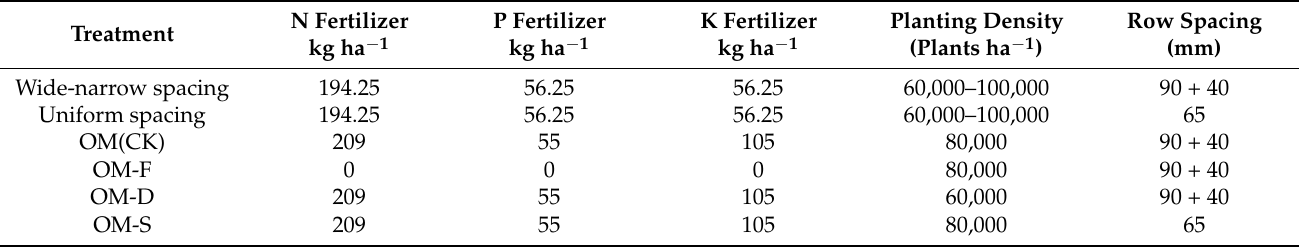
Table 5. Treatment design for fertilization, planting density and row